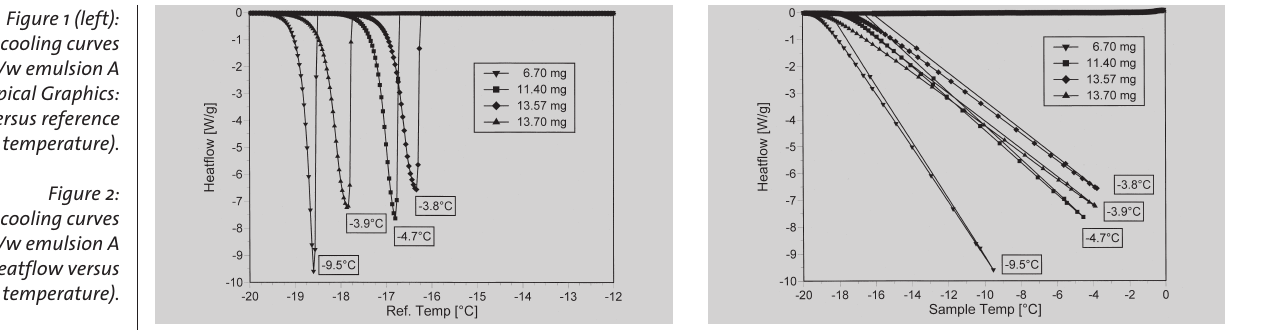
100 rad/s with a plate gap of 1 mm and a con-